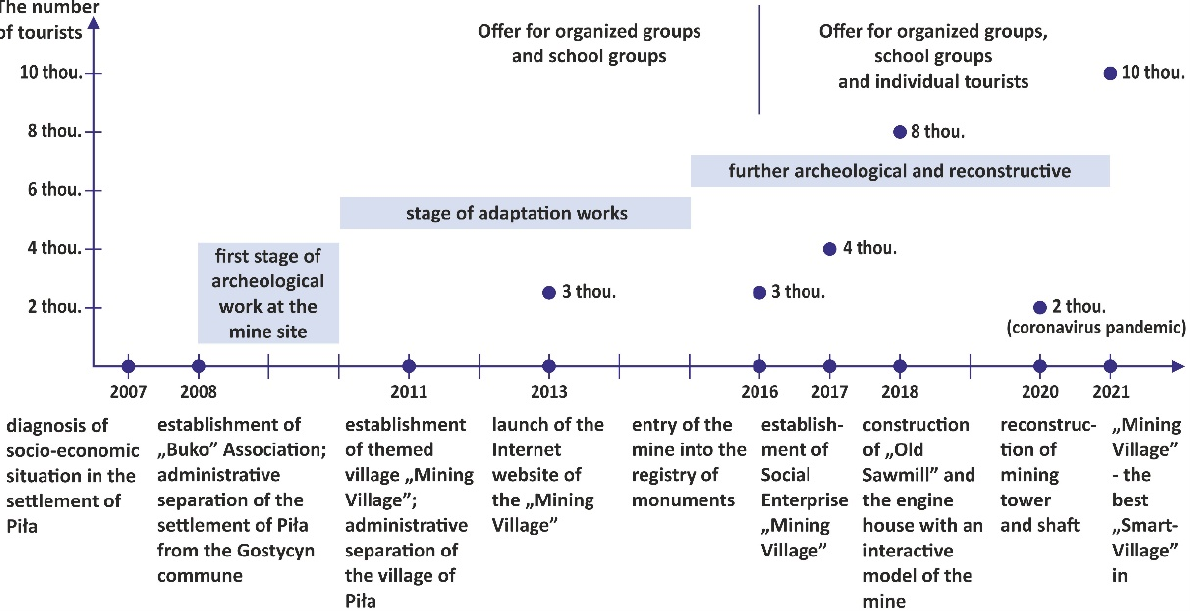
Figure 7. Most notable endeavours in the history of “Mining Village” and the number of tourists. Source: own elaboration based on [42] and oral interviews with W. Weyna.